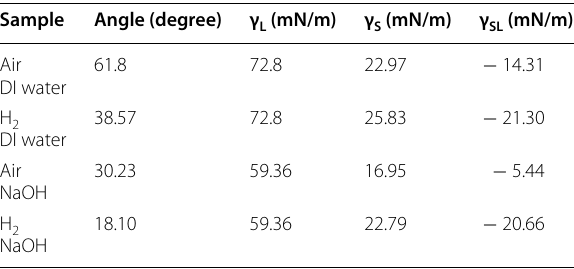
Table 2 Interfacial free energy calculation Sample Angle